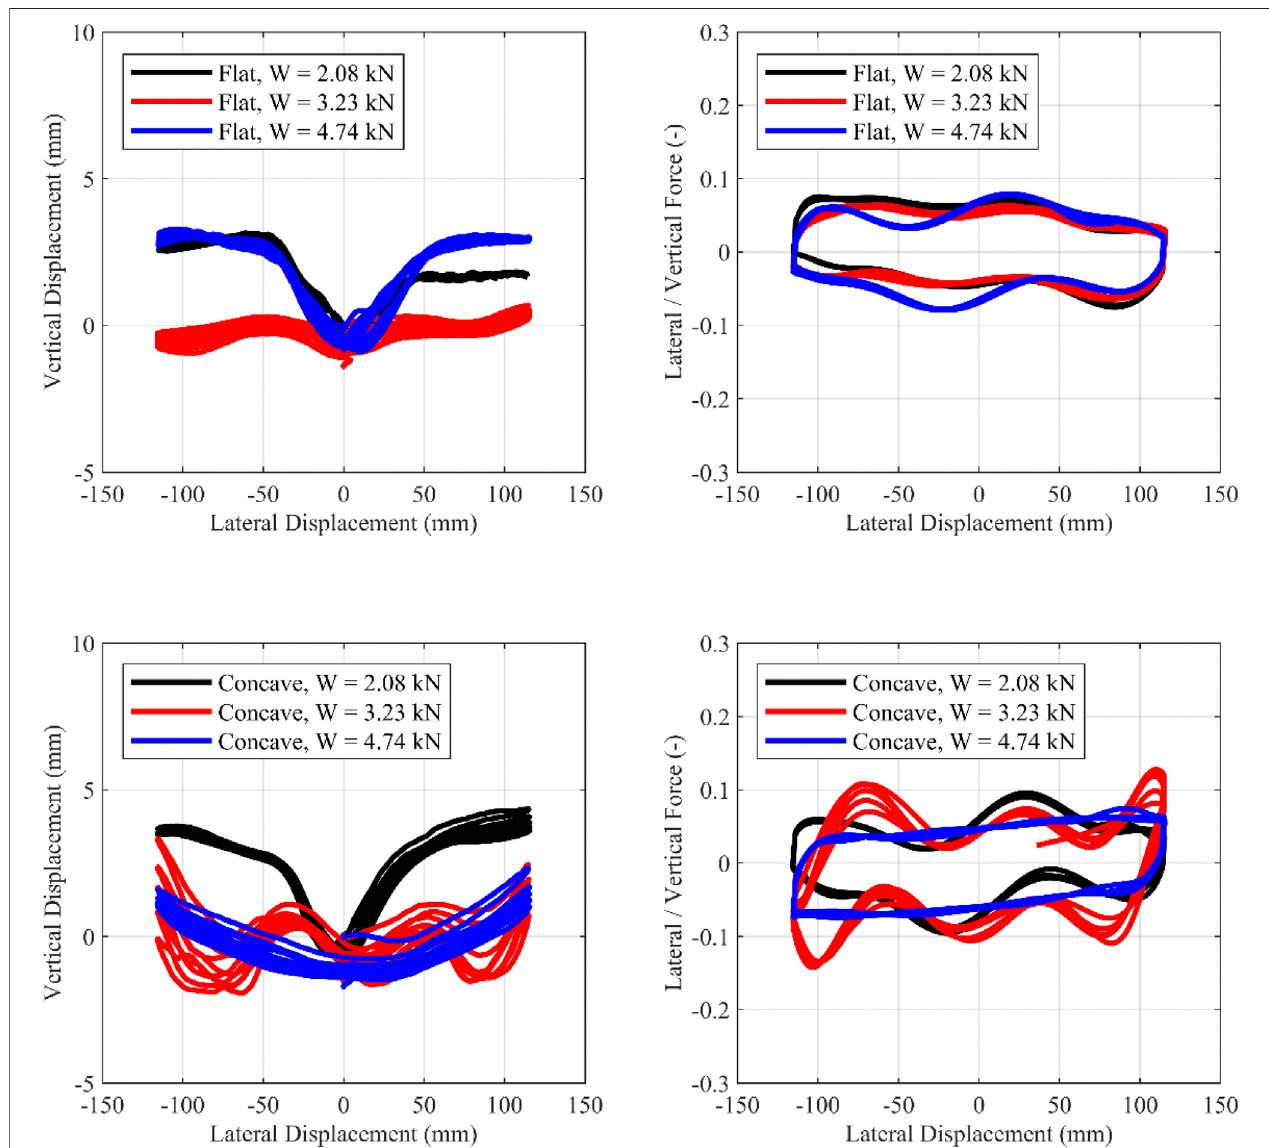
FIGURE 11 | Cyclic motion ± 115 mm. In fl uence of the vertical load. Left , Vertical-horizontal displacement; Right , Lateral/Vertical force — Lateral displacement.